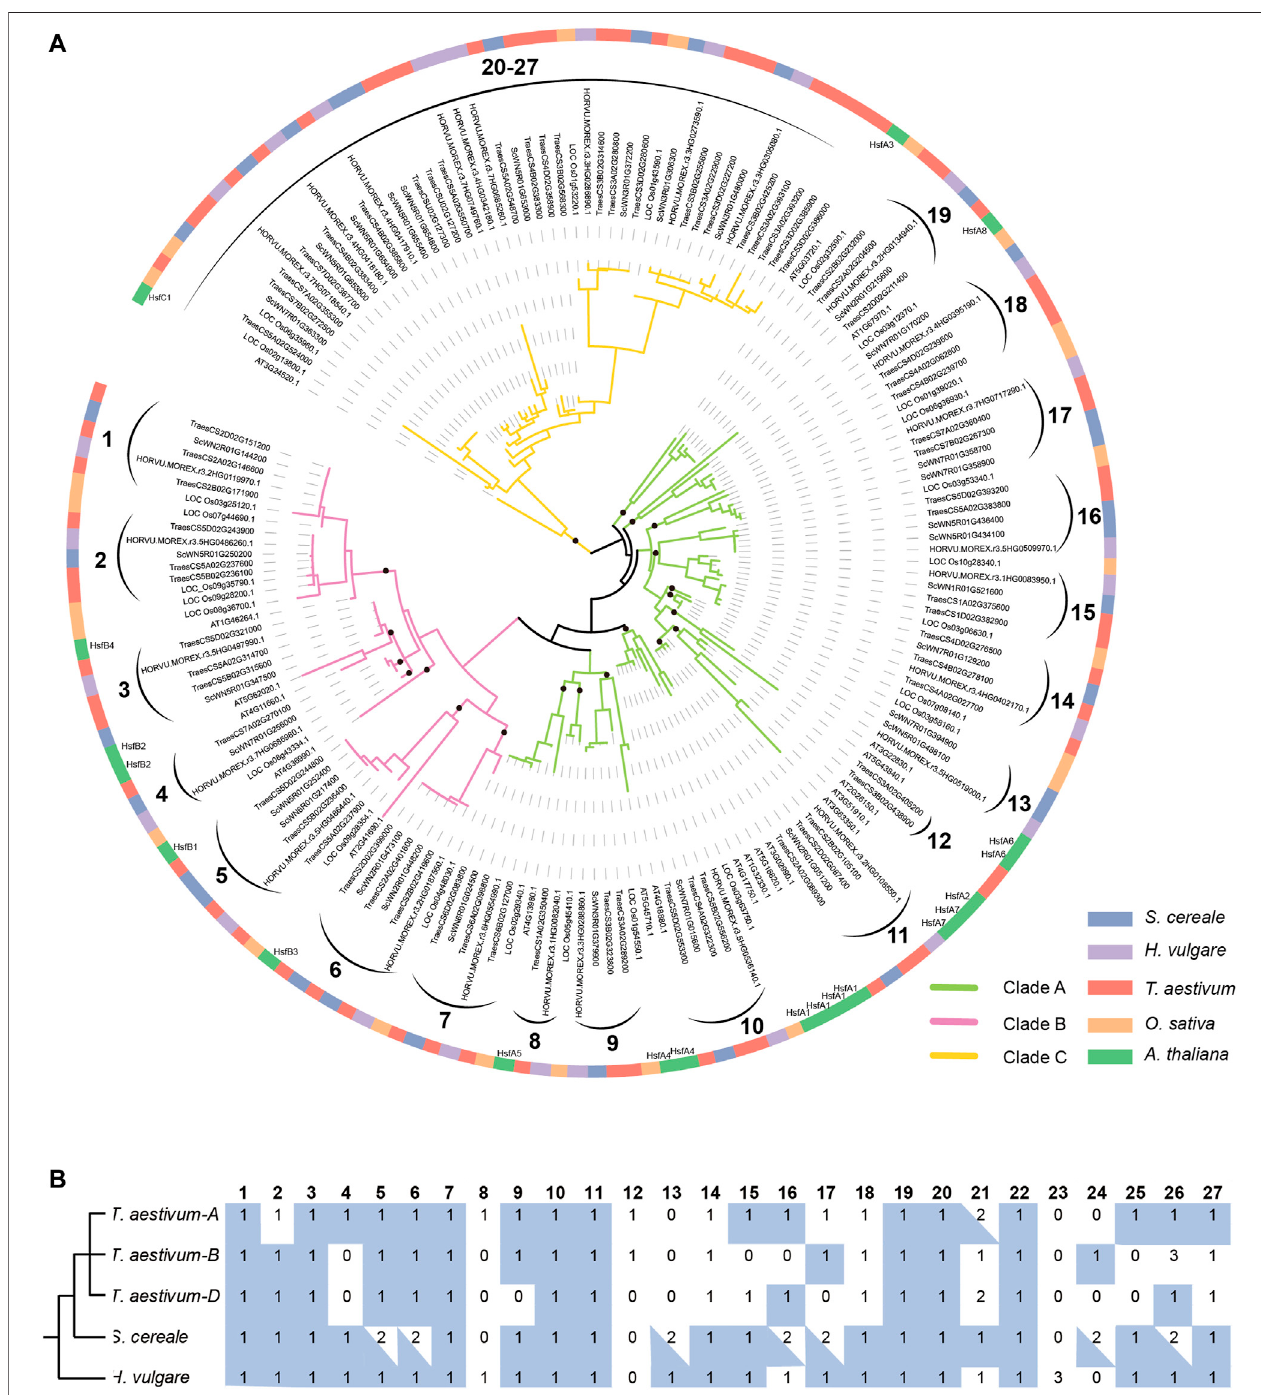
FIGURE 3 | Phylogenetic analysis of HSF genes from S. cereale, H. vulgare, T. aestivum, O. sativa and A. thaliana . (A) . A phylogeny of HSF genes from S. cereale , H. vulgare , T. aestivum (three subgenomes), O. sativa and A. thaliana based on the amino acid sequences of the HSF domain. Black brackets indicate a group of orthologousHSFsinTriticeae.Theidenti fi cationofclassCTriticeaeHSForthologousgroupwerebasedonanadditionalphylogenyprovidedin SupplementaryFigure S2 , which is constructed by using the full-length protein sequences encoded by HSFC genes. Black dots on the basal of several lineages indicate ancestral HSF lineages ofmonocots and dicots. (B) . Thenumber ofHSF genesfrom differentspecies in each Triticeae HSF orthologous group. Ablue rectangle background indicates the HSF gene and HSF genes from at least one other species are in collinear blocks. A blue triangle indicates one of the HSFs in this orthologous group has a collinear relationship with HSF genes from at least one other